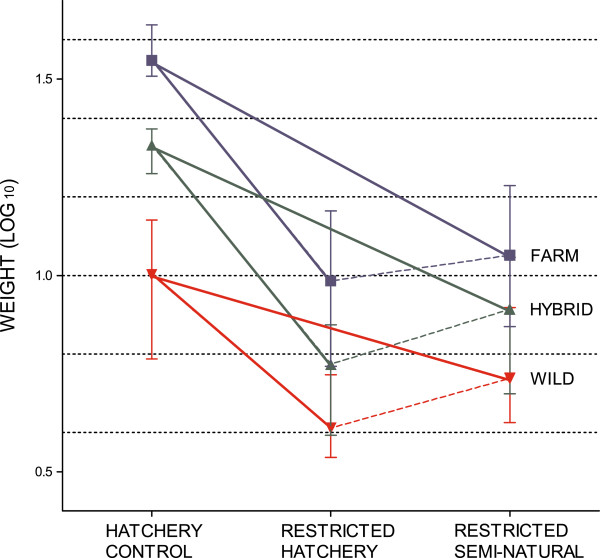
Growth reaction norms across treatments, experiment II. Mean weight (log10) norm of reaction across all treatments for salmon of farmed, hybrid and wild origin. Replicated tanks are pooled. Error bars show the range of the family means within each experimental group. The elevations of the reaction norms were significantly different between the treatments, as well as between the farmed, hybrid and wild salmon. Wild salmon displayed a significantly flatter negative reaction norm slope between the hatchery control and the restricted hatchery treatments than the hybrid and farmed salmon, which displayed similar and steeper slopes. All groups displayed significantly different reaction norm slopes between the hatchery control and the restricted semi-natural treatment, with farmed salmon displaying the steepest slope, followed by the hybrid salmon. Salmon of all origin displayed similar positive reaction norm slopes between the restricted hatchery treatment and the restricted semi-natural treatment.